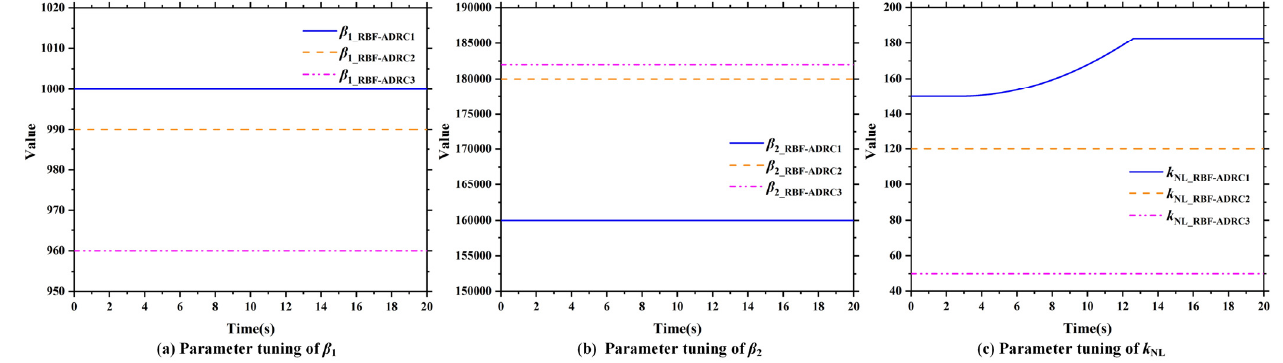
Figure 14. The ESO and NLSEF parameter adjustment curves under tension disturbance (300 m/min).